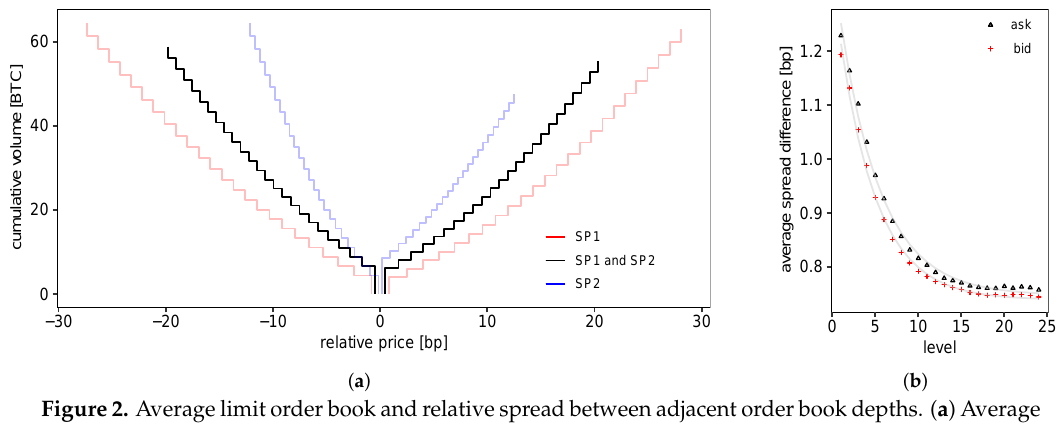
Figure 2. Average limit order book and relative spread between adjacent order book depths. ( a ) Average limit order depth. We plot the time-averaged spread (relative to the respective mid-price) and time-averaged cumulated volume for each level of the order book and for the different subperiods (SP1, SP2) of the data. ( b ) Time-averaged relative spread difference between adjacent depth steps. The gray lines are fits of exponential functions to guide the